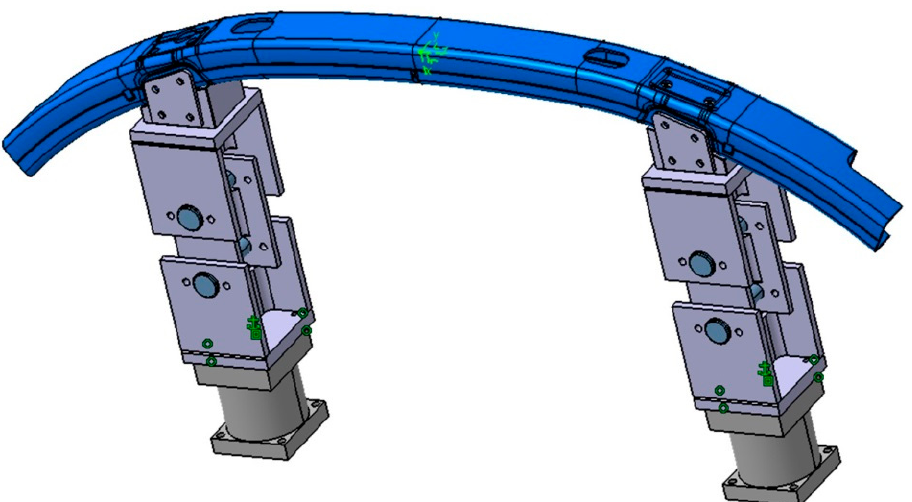
Figure 3. Clamping of the bumper bracket for the drop tower tests: solid bearing ( left ) and articulated bearing ( right ) with load cells.